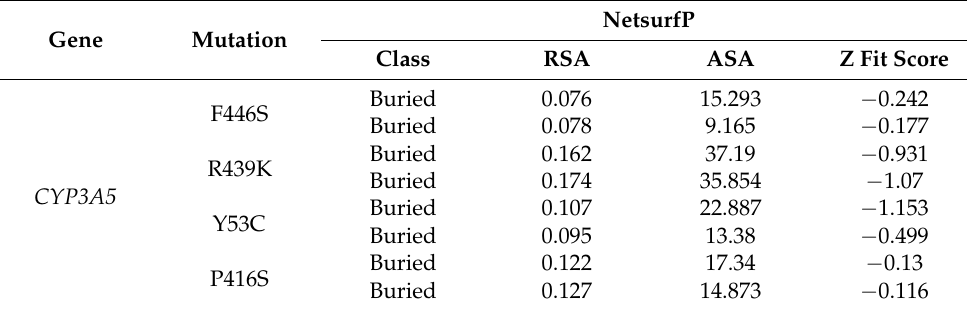
Table 7. Prediction of relative surface accessibility of CYP3A5 through